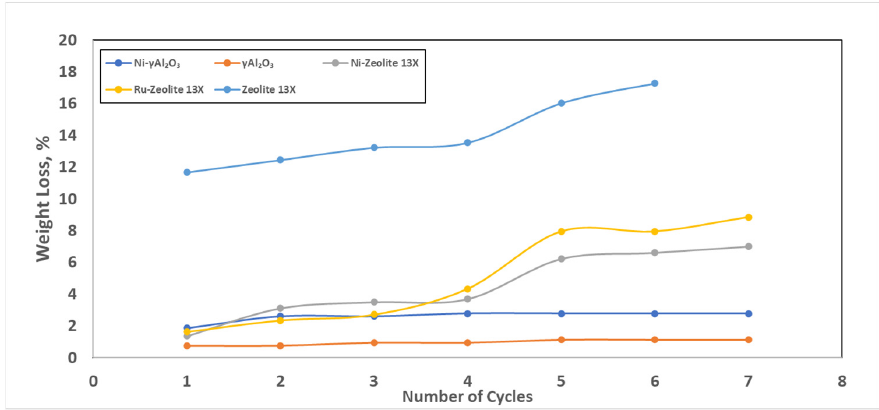
Figure 4. Results of the ultrasound adhesion test.